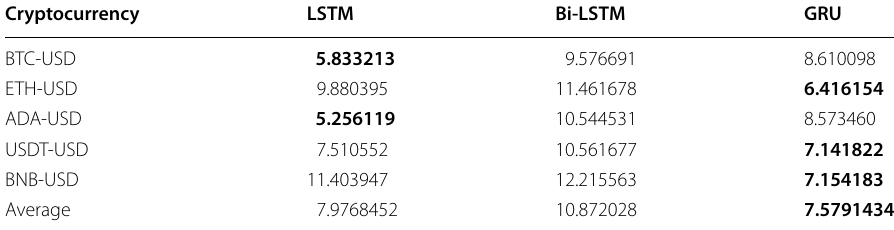
Table 4 Execution time